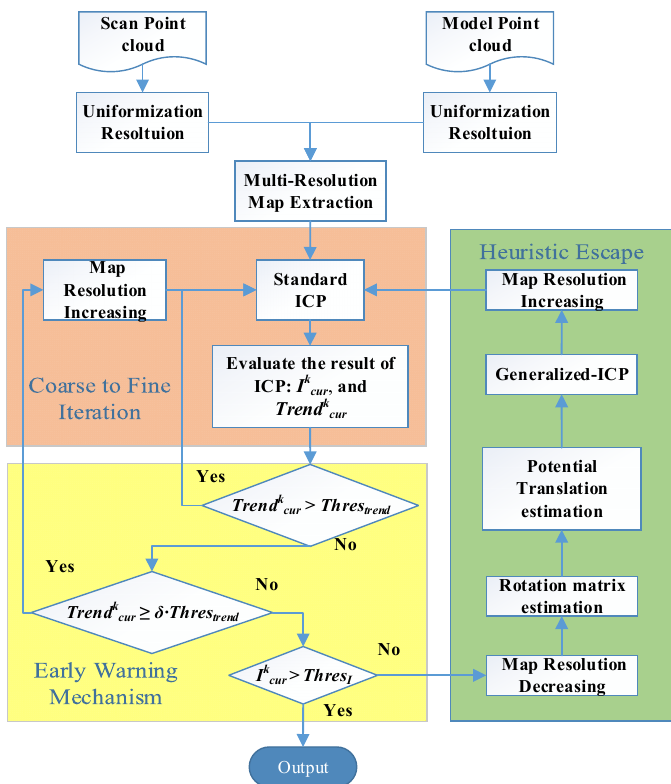
Figure 1. Pipe flow of the enhanced ICP: Coarse-to-Fine Iteration works as a Multi-Resolution ICP registration step; Early Warning Mechanism is introduced to estimate the potential local optima; Heuristic Escaping help the data point cloud escape from the current local optimal by estimating the potential optimal transformation.